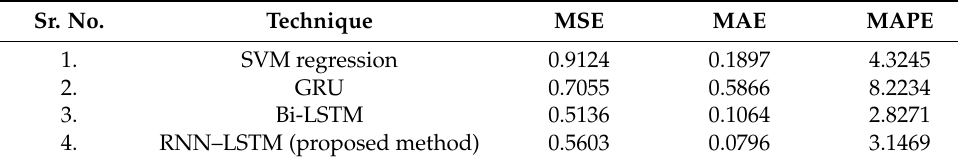
Table 3. Comparison of model’s performance evaluated. Sr.